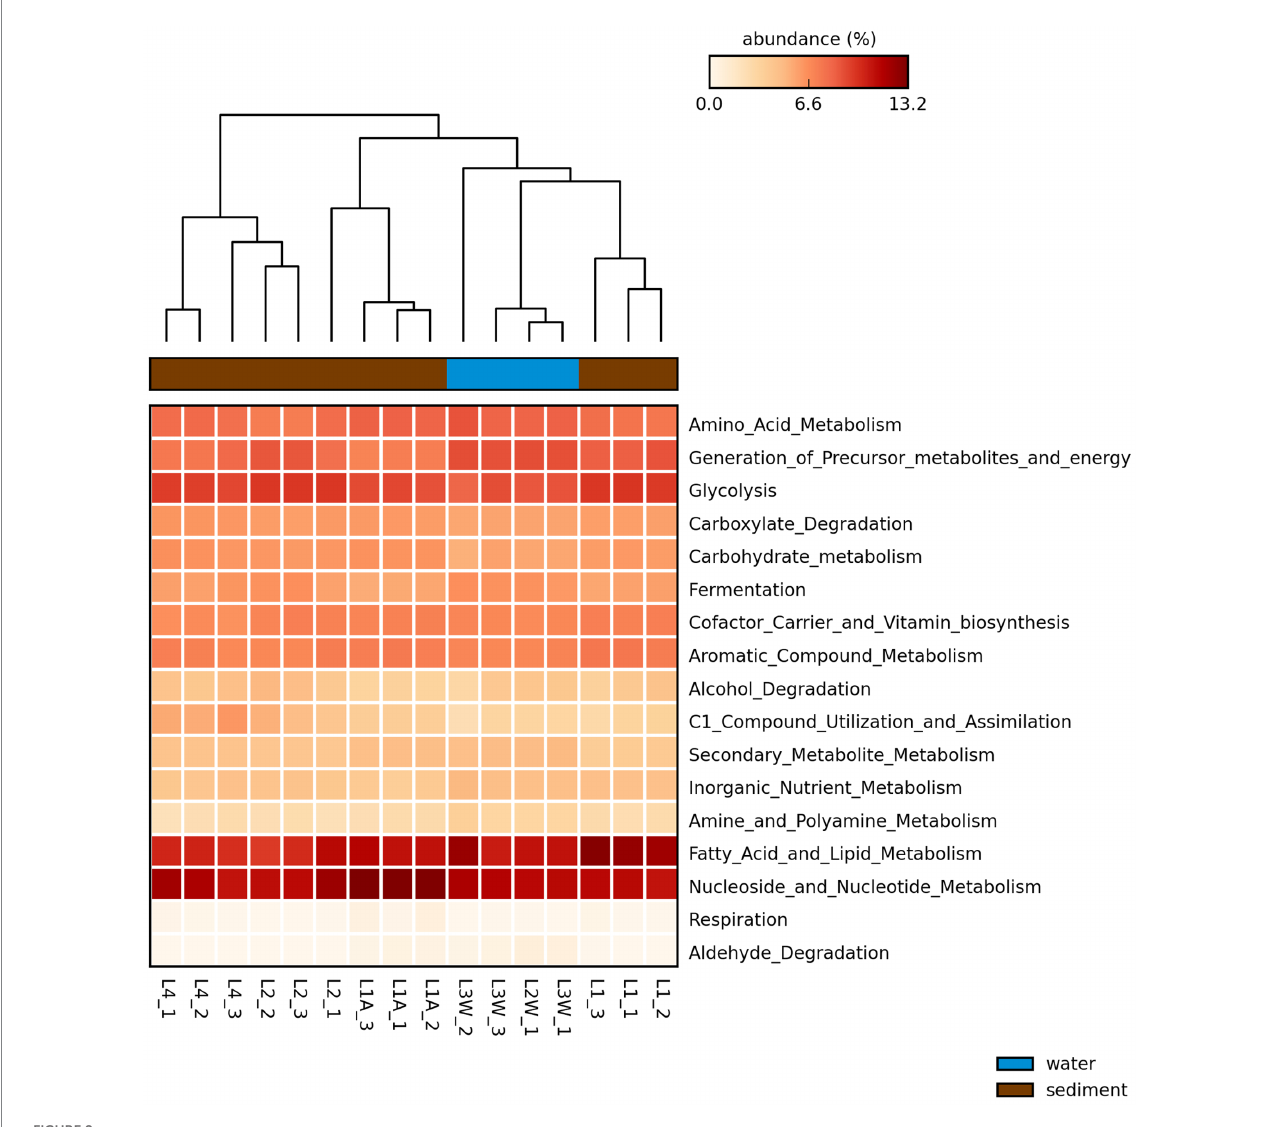
FIGURE 8 Heatmap of the proportion of sequences (5) of the predicted pathways by PICRUSt2 generated through STAMP with the average neighbor (UPGMA) method using the default parameters. Larger proportion of abundances are represented in dark red and smaller values in light yellow. Sample replicates names are included in the